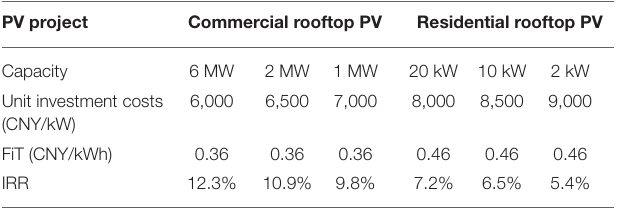
TABLE 6 | The impact of initial investment on the LCOE and IRR of rooftop PV in Beijing. PV project